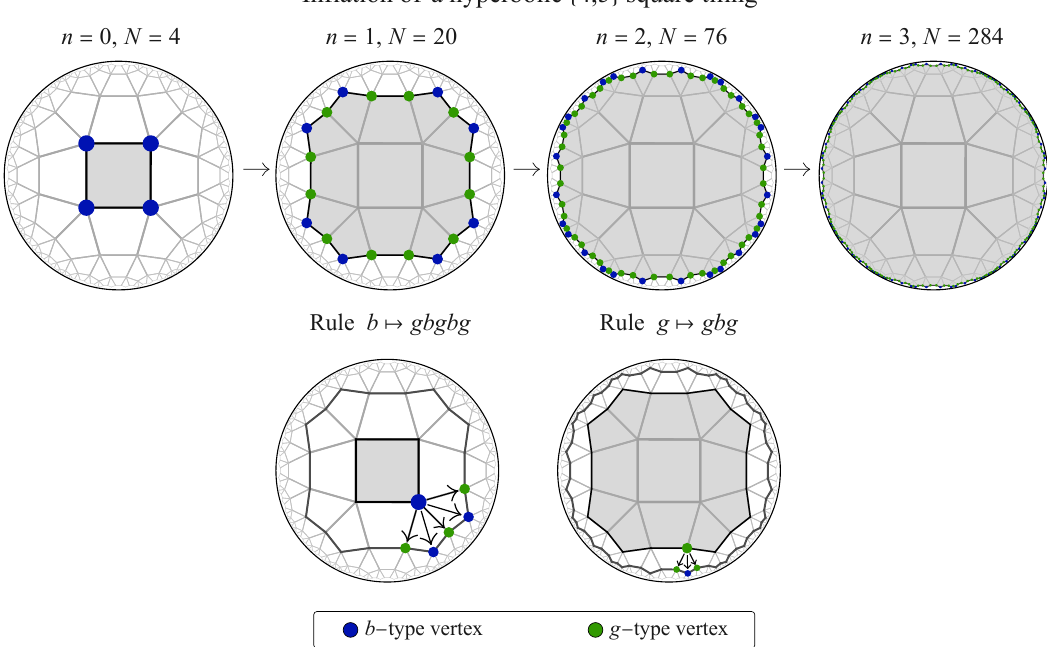
Figure 18 . Iterative construction of a regular hyperbolic tiling through inflation rules (2.2) of a { 4 , 5 } square tiling. As in the { 3 , 7 } case in figure 2, the number of boundary sites N increases exponentially with the number of iterations n . The vertex types b, g denote boundary vertices with zero and one adjacent edges connected to the previous inflation layer,